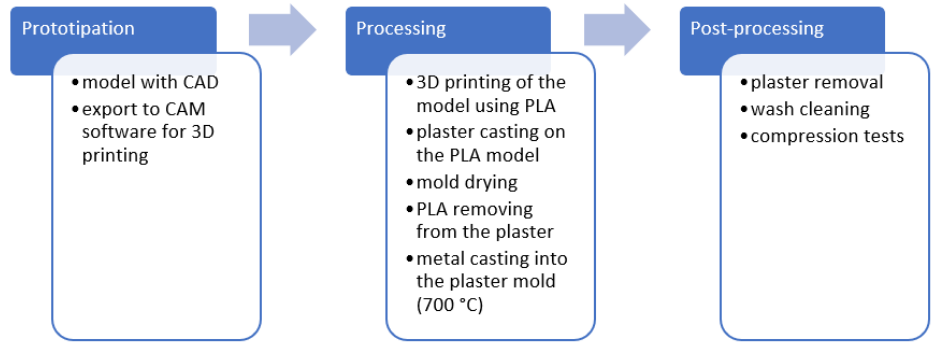
Figure 2. Scheme of the production process.